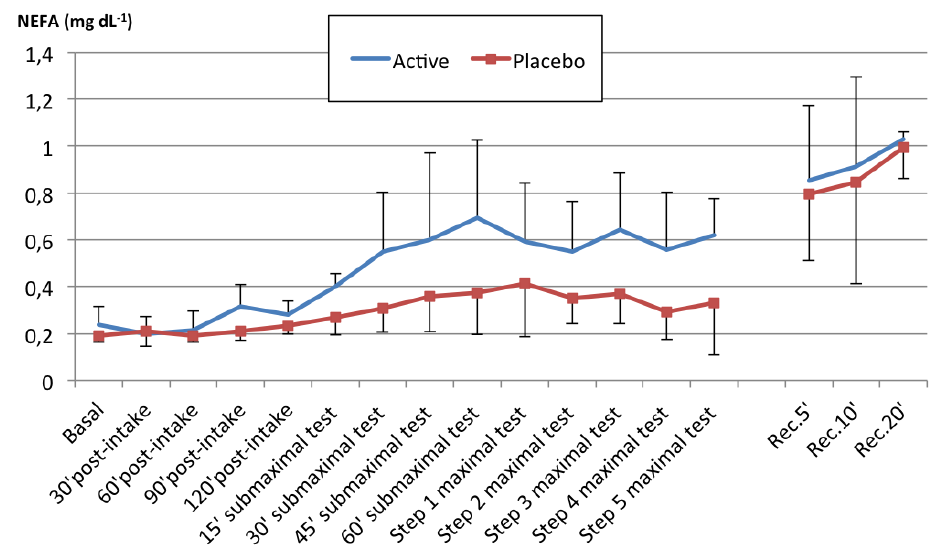
Figure 2. Evolution in NEFA plasma values after active and placebo supplementation. Results are the mean ± standard deviation (SD). A statistically significant increase in the mean values following active supplementation was found (0.09 mg· dL −1 ; p < 0.001). Abbreviations: NEFA = non-esterified fatty acids.